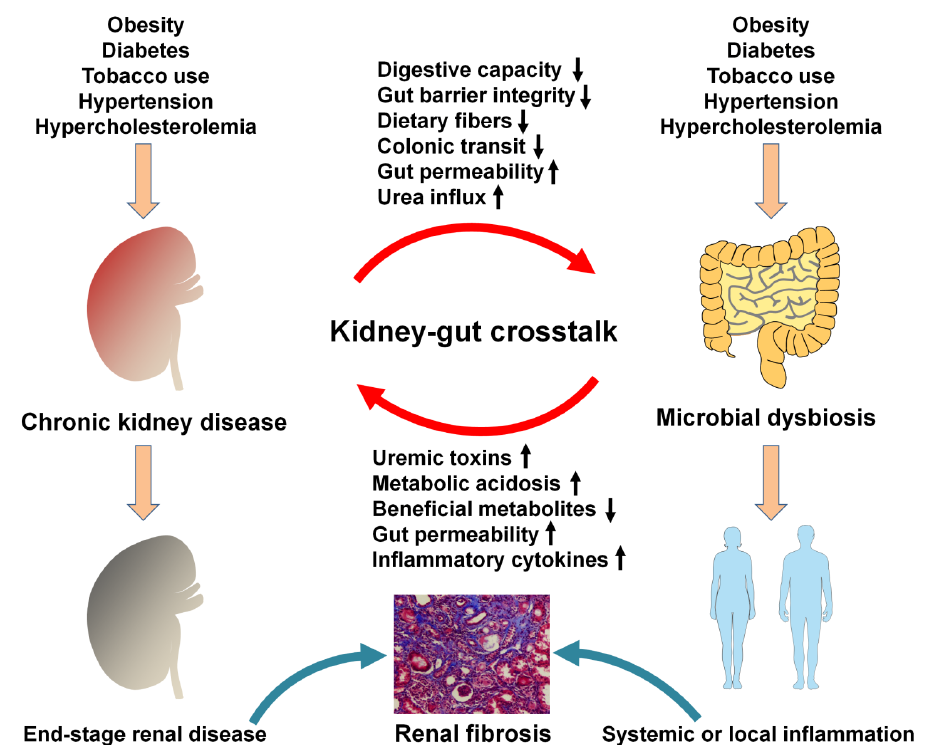
Figure 1. Mechanisms involved in the relationship between gut microbial dysbiosis and CKD. CKD led to the dysbiosis of gut microbiota that destroys intestinal mucosal barrier, allowing live bacteria or their metabolites to enter the bloodstream. Leakage and translocation of their metabolites across gut barrier to the circulation can trigger oxidative stress and inflammation that finally leads to local tissue and vascular